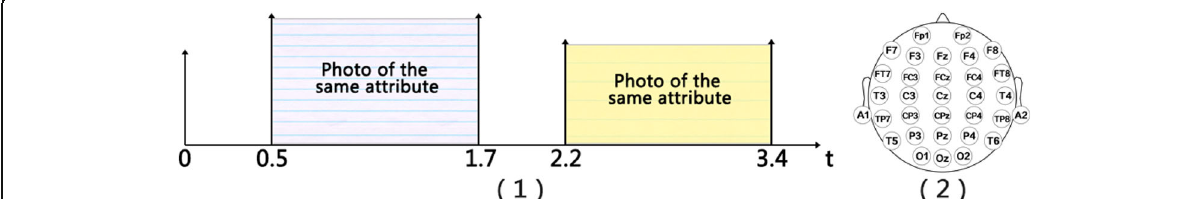
Fig. 1 Image stimulation experiment